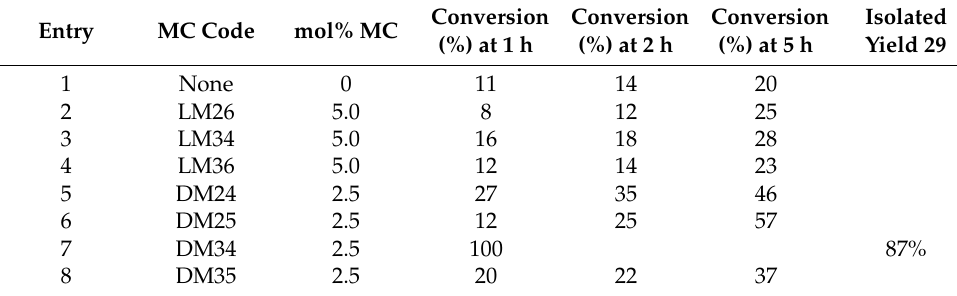
Table 3. Effect of the macrocycle on catalyzing the click reaction of 1-octyne (R = n -Hexyl).